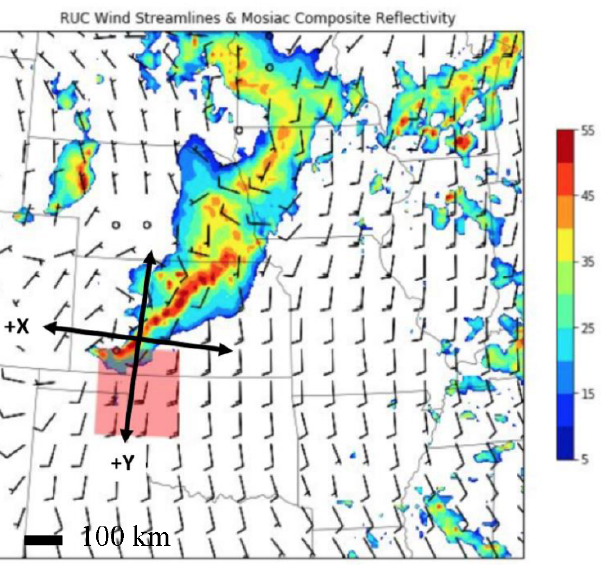
Figure 2. Mesoscale Convective System (MCS) case on 2 June 2014. Red area represents the Obs- inflow, and the axes represent the rotated coordinate system aligned with the 750 m AGL flow. Filled contours show mosaic composite reflectivity (dBZ as indicated by color bar), and RUC wind barbs are in m s −1 . Distance scale shown at lower left.